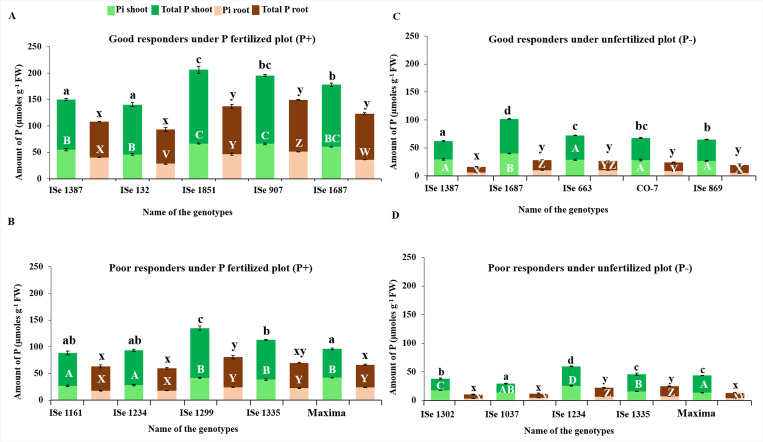
Inorganic (green) and total P assay (brown) for the five each of high performers and low performers of foxtail millet genotypes under unfertilized (P-) and P fertilized (P+) conditions in the natural field.A, high performers under P+; B, low performers under P+; C, high performers under P-; D, low performers under P-. The letters over the bars indicate statistically significant difference if the letters are different as p<0.05. The vertical lines indicate error bars.